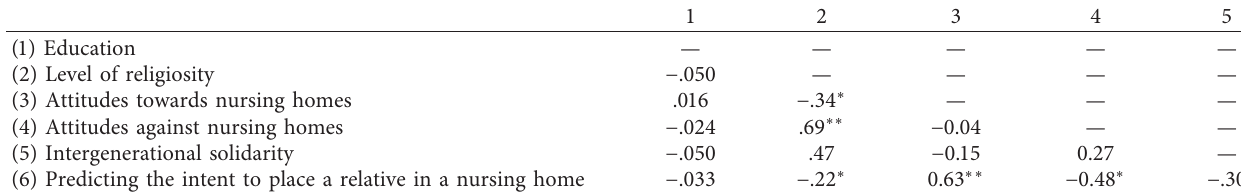
Table 2: The connections between the research variables ∗